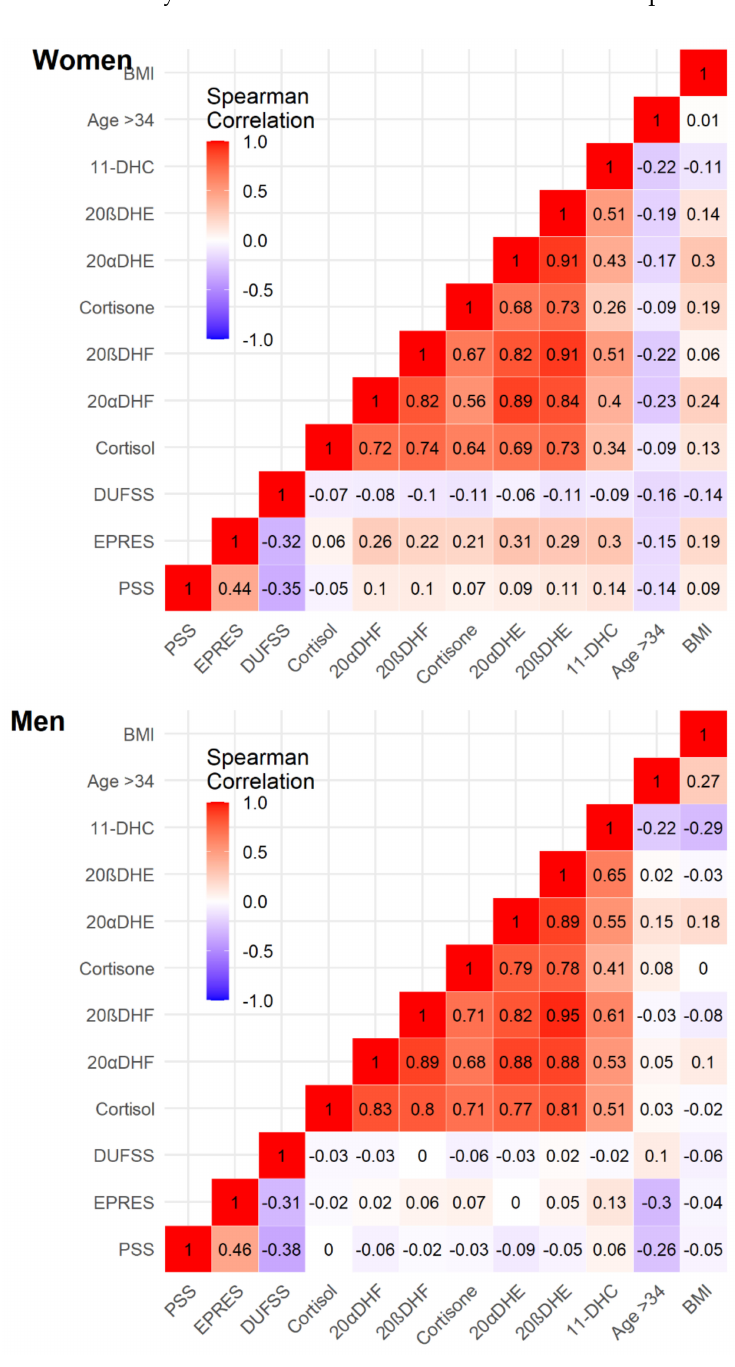
Figure A1. Bivariate Spearman correlations between the variables in study stratified by